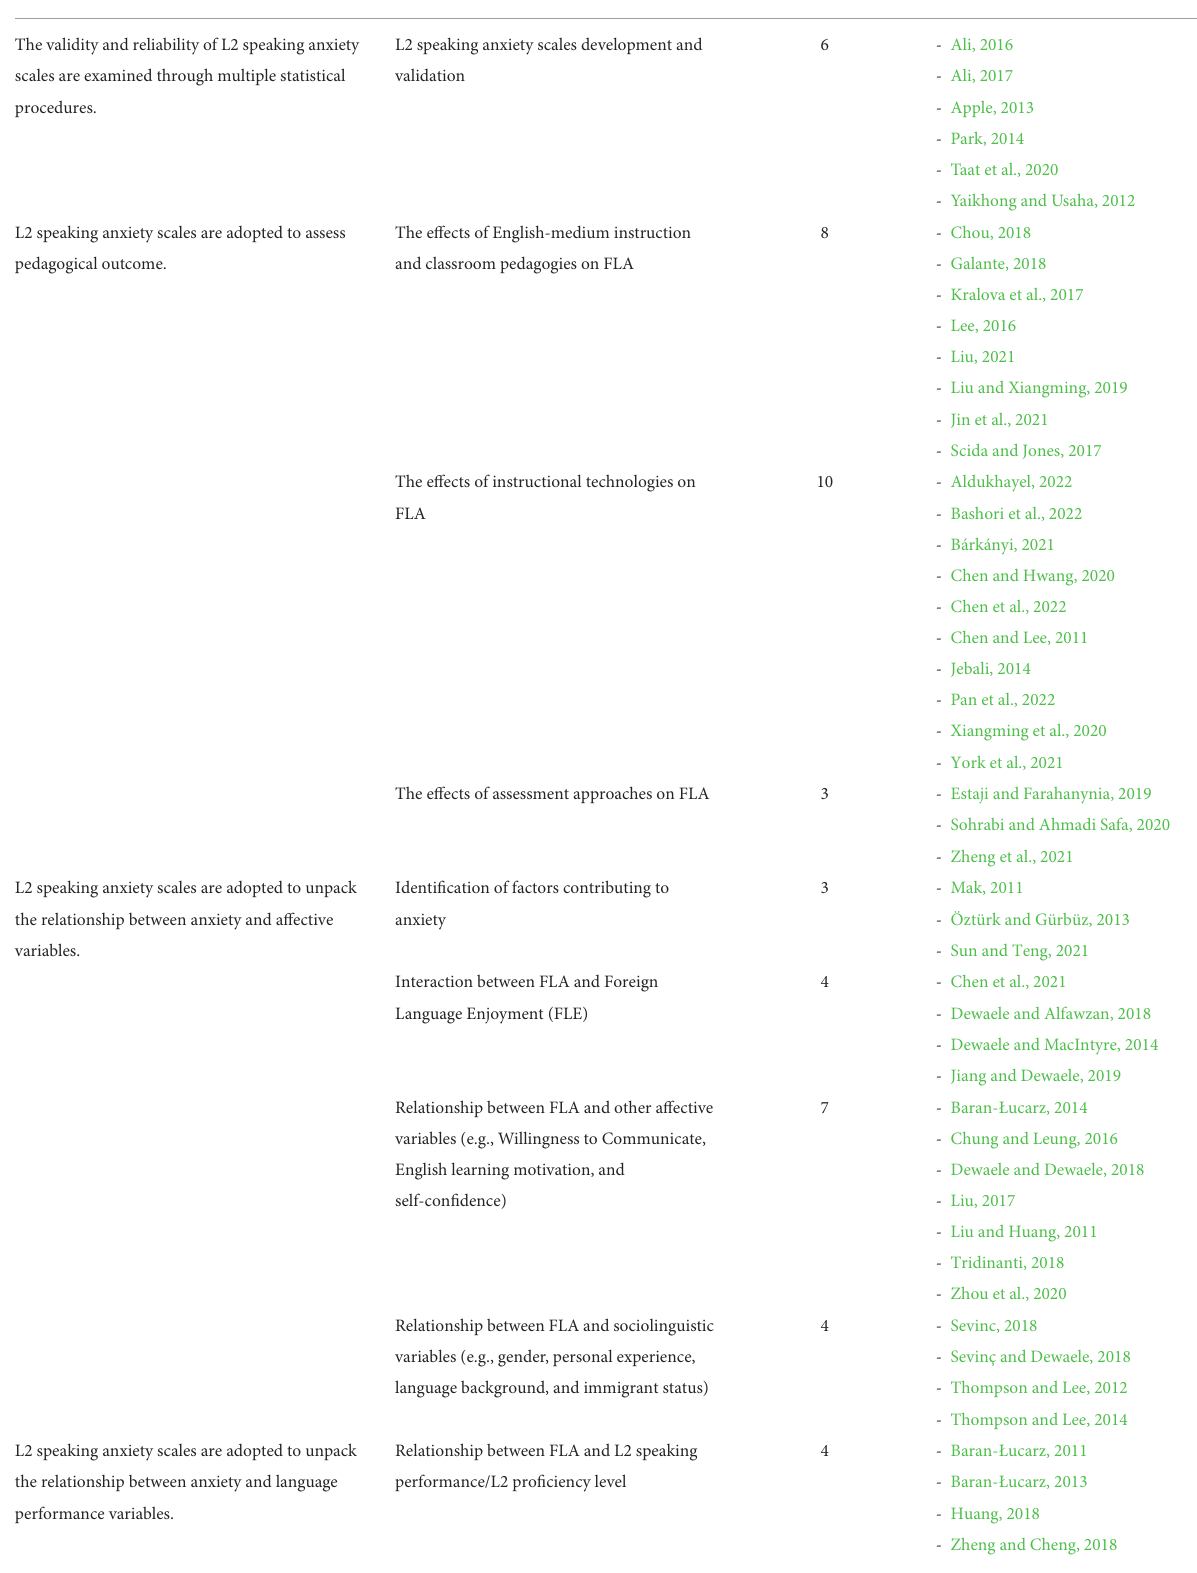
TABLE 1 Articles reviewed in identification of scales assessing L2 speaking anxiety.